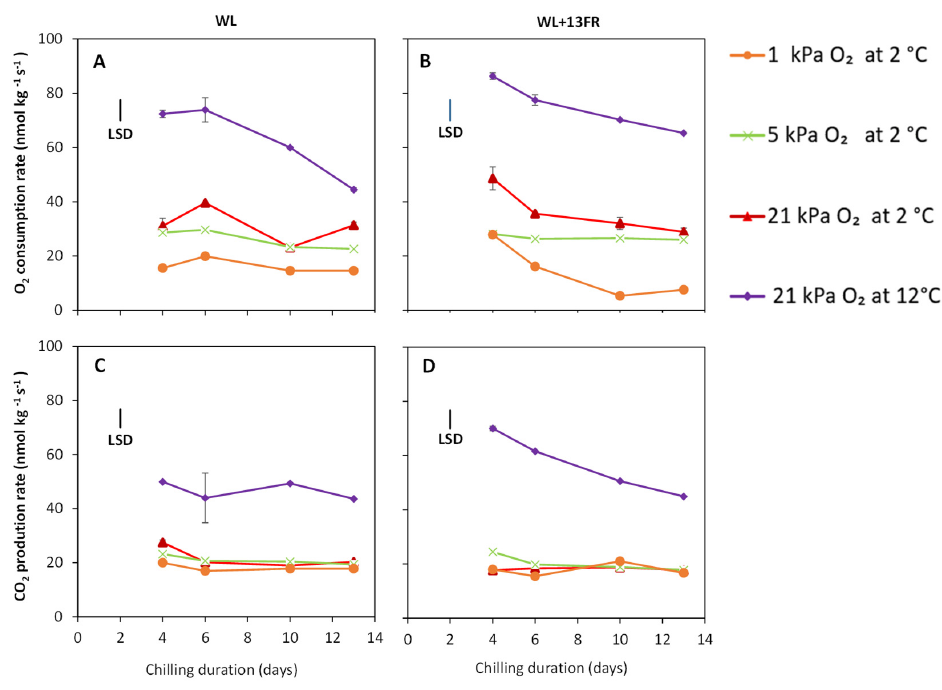
Figure 8. Respiration MG tomatoes cultivated under white LED light (WL) without- ( A , C ) or with far red lighting during cultivation ( B , D ) indicated as oxygen consumption ( A , B ) or CO 2 production ( C , D ) measured during cold storage at 2 or 12 °C. Orange, green, red and purple lines and symbols indicate 1, 5 and 21 kPa O 2 (low oxygen control), and 21 kPa O 2 at 12 °C (temperature control), respectively. The average O 2 or CO 2 production rates with indicated standard error are shown for two replicates from each respective container ( n = 2) during cold storage at 2 °C or 12 °C. LSD values ( p < 0.05) are indicated per panel.